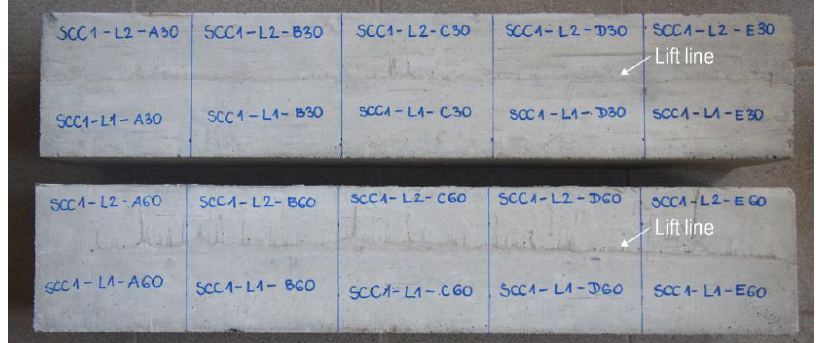
Figure 2. Test elements with visible lift lines (Variant A of placement technology).